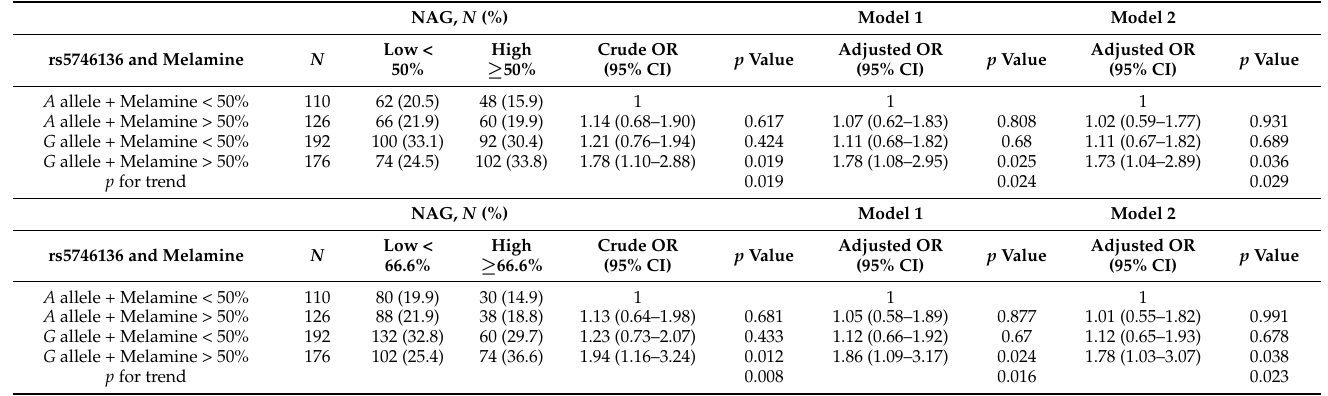
Table 6. Combined effects of MnSOD genetic polymorphism (rs5746136) and urine melamine levels on the risk of a high urinary marker of renal tubular injury, NAG, in 302 calcium urolithiasis patients. NAG, N (%) Model 1 Model